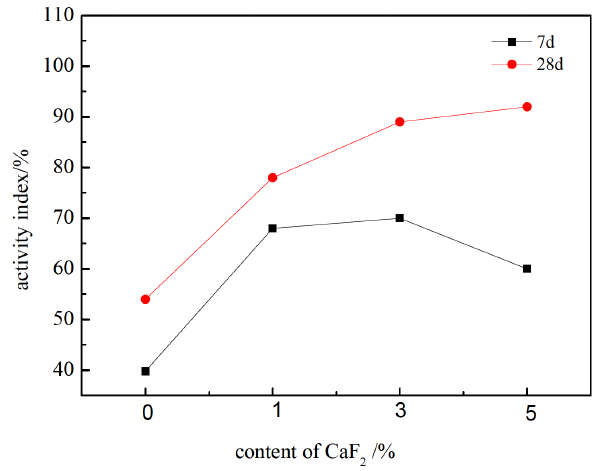
Figure 1: Activity index of the reconstructed steel slag with different CaF 2 contents.